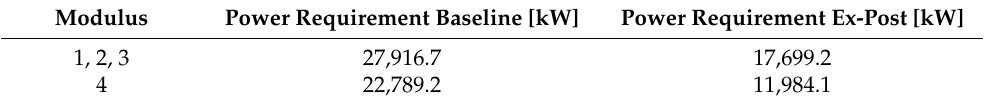
Table 1. Power requirements in ex-post and baseline configurations for the different Table 1 . Power requirements in ex-post and baseline con fi gurations for the di ff erent moduli.